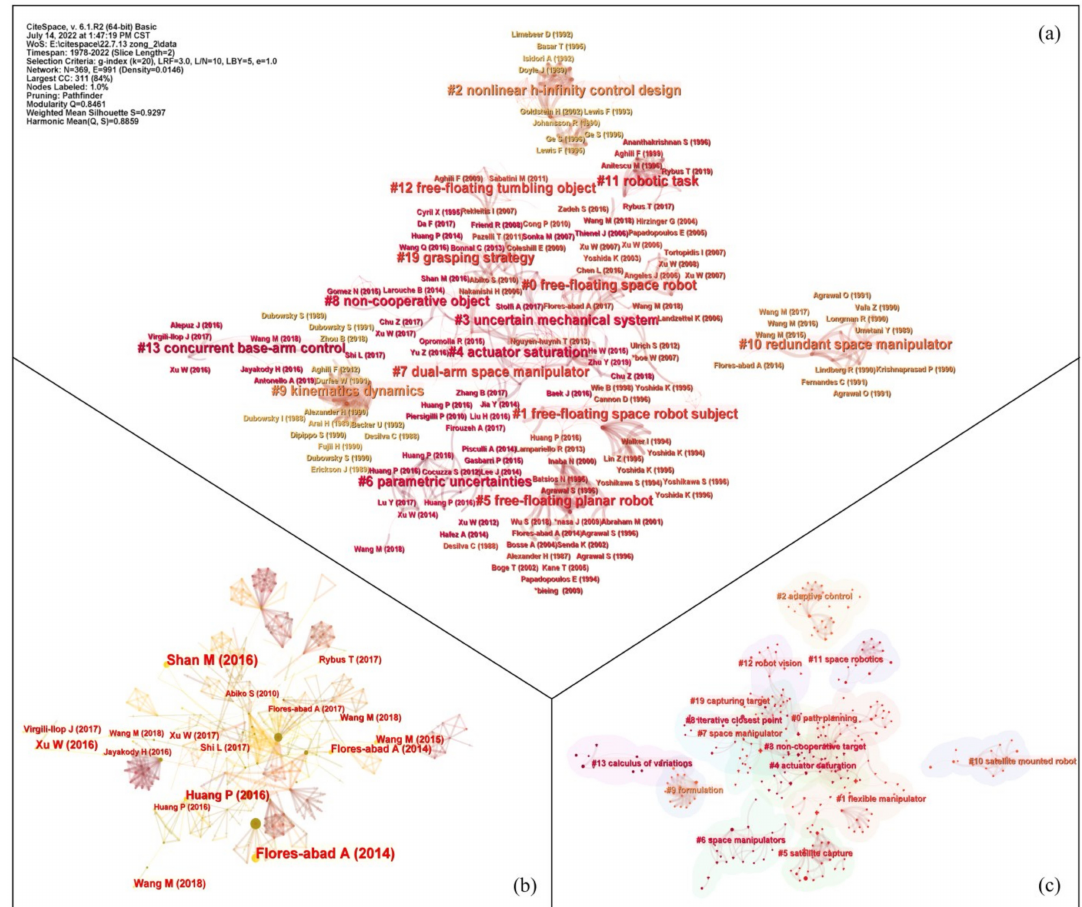
Figure 2. Citespace analysis results with parts: ( a ) co-word of title; ( b ) co-cited author; ( c ) keyword